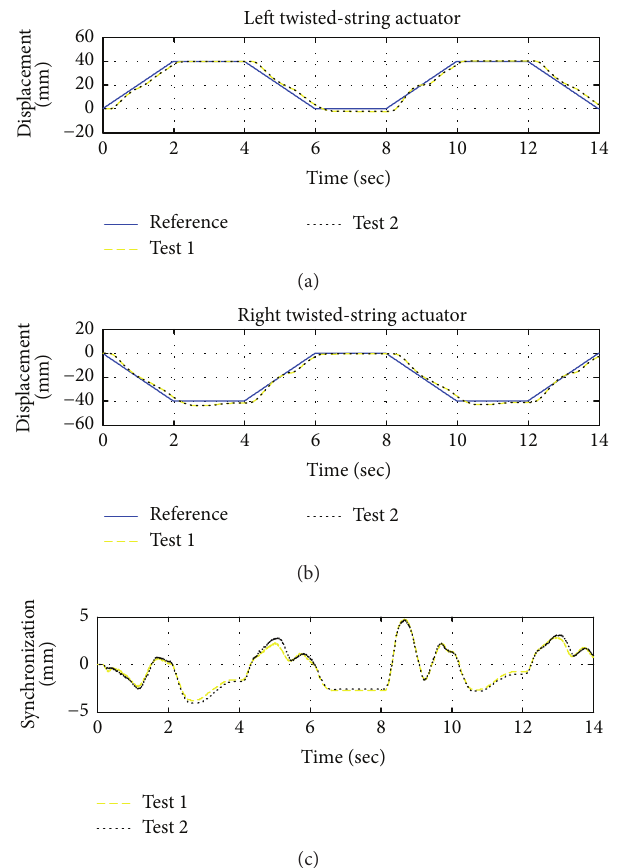
Figure 9: Experimental outcome of PID controller (trapezoidal motion): (a) comparison between reference trajectory and actual trajectories of left actuator; (b) comparison between reference tra- jectory and actual trajectories of right actuator; (c) synchronization errors between left and right twisted